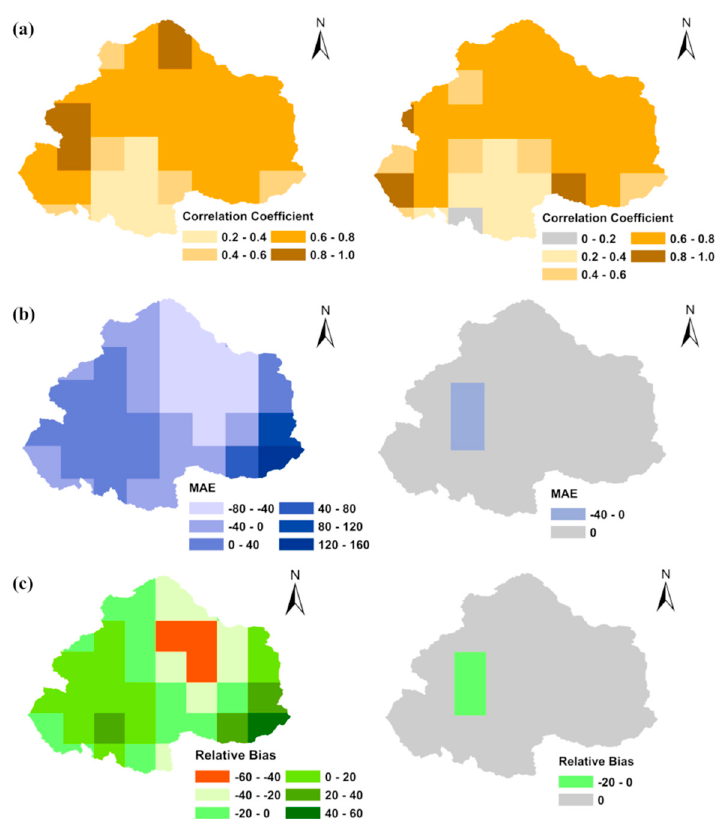
Figure 9. Spatial plot of performance evaluation parameters namely ( a ) correlation coefficient ( r ) ( b ) mean absolute error (MAE) and ( c ) relative bias (RBIAS), before (left) and after (right) bias correction of TRMM precipitation for the pre-monsoon season.